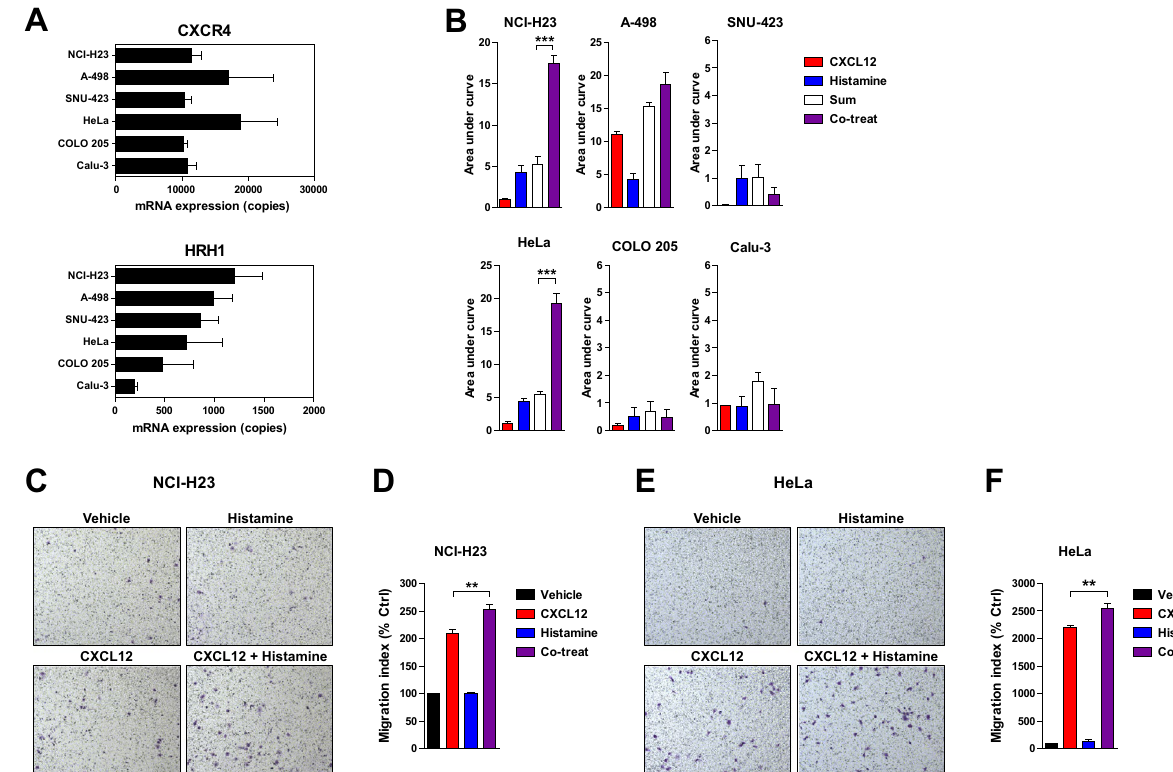
Figure 8. The synergistic effect of CXCR4 and HRH1 on calcium signaling and cell migration has been observed in other cancer cell lines. ( A ) RT ‒ qPCR analysis of the expression of CXCR4 (upper panel) and HRH1 (lower panel) in NCI-H23, A-498, SNU-423, HeLa, COLO 205, and Calu-3 cells. Data are expressed as mean ± s.e.m. (n = 3). ( B ) Cells were stimulated with 3 nM CXCL12, 100 nM histamine, or both, and intracellular calcium flux was measured. The area under the curve of each calcium response was calculated and normalized to that of CXCL12. Data are expressed as mean ± s.e.m. (n = 3). *** P < 0.001. ( C ) Representative images of NCI-H23 cells migrated by vehicle, 10 nM CXCL12, 100 nM histamine, or both agonists. ( D ) Quantification of migration shown in ( C ). Data are expressed as mean ± s.e.m. (n = 3). ** P < 0.01. ( E ) Representative images of HeLa cells migrated by vehicle, 10 nM CXCL12, 100 nM histamine, or both agonists. ( F ) Quantification of migration shown in ( E ). Data are expressed as mean ± s.e.m. (n = 3). ** P <